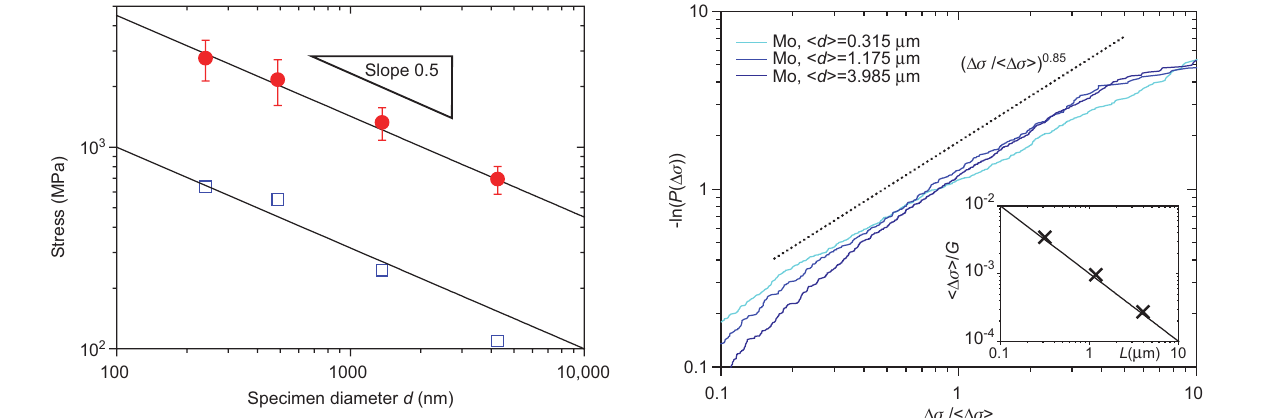
Figure 6 Cumulative probability distributions of stress increments determined in stress-controlled compression of [100]-oriented Mo micropillars of different sizes. The straight line is a Weibull distribution with parameter 0.87. Inset, Mean stress increment as a function of sample diameter.